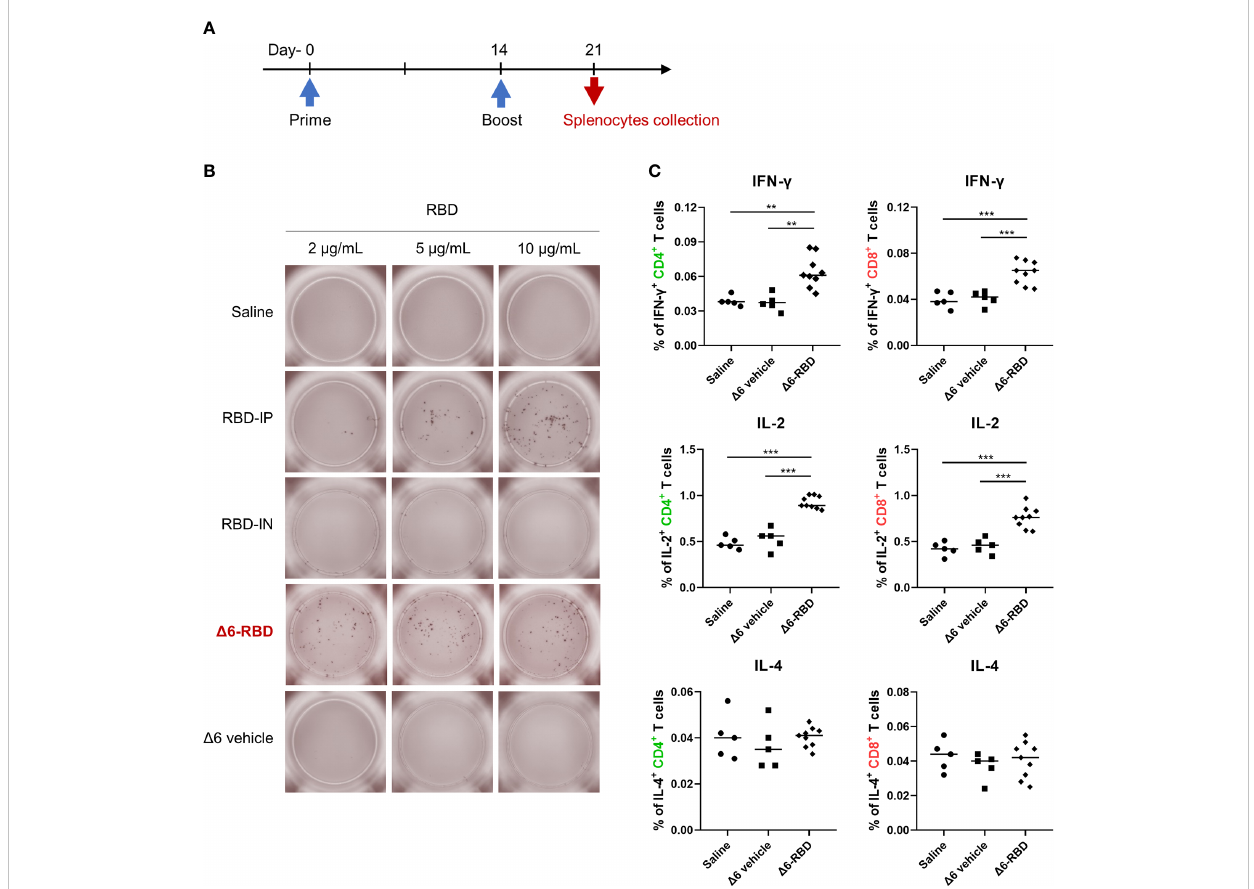
FIGURE 4 Induction of cellular responses by D 6-RBD vaccination. (A) The vaccination regimen was performed. Mice were immunized at days 0 and 14, and spleens were isolated on day 21. The spleens soaked in 5 ml lymphocyte separation medium were dissociated by pressing it through the cell strainer (70 m m) using a syringe plunger. The splenocyte suspension was centrifuged at 800 x g for 30 min to obtain lymphocytes for cytokine detection. (B) ELISPOT analysis of lymphocytes. Cells were restimulated (20 hr) with recombinant RBD protein in the microwell of an ELISPOT plate that was precoated with the anti-mouse IFN- g (5 m g/ml). Biotinylated anti-mouse IFN- g (2 m g/ml) was used to detect the captured IFN- g . Spots were visualized using Streptavidin-HRP enzyme and AEC substrate. (C) Cytokine pro fi ling of lymphocytes by fl ow cytometry. Mice were immunized intranasally with 5 × 10 7 CFU of the D 6 vehicle (n=5) and D 6-RBD (n=9), and lymphocytes restimulated (9 hr) with a peptide pool consisting of 20- mers (10 m g/ml) spanning the SARS-CoV-2-S RBD were detected for the expression of IFN- g , IL-2 and IL-4 in CD4 + and CD8 + cells. *, P <0.05; **, P <0.01; ***, P